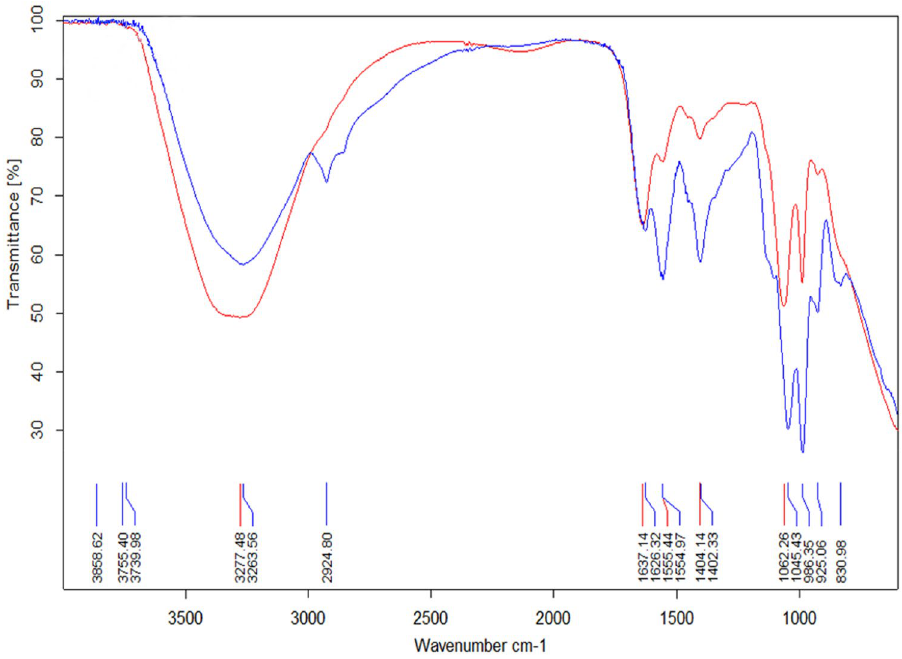
Figure 7. FTIR analysis of P. thoriotolerans sp. nov. AM3 EPS (blue) and EPS Th+ (red) (image created in OPUS, Bruker